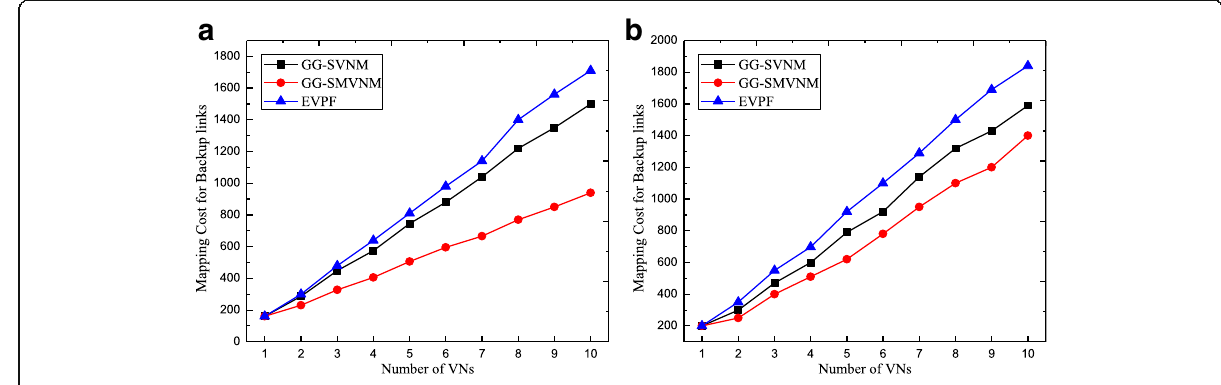
Fig. 9 Mapping costs for backup links. a Simulation results on Net-1. b Simulation results on Net-2